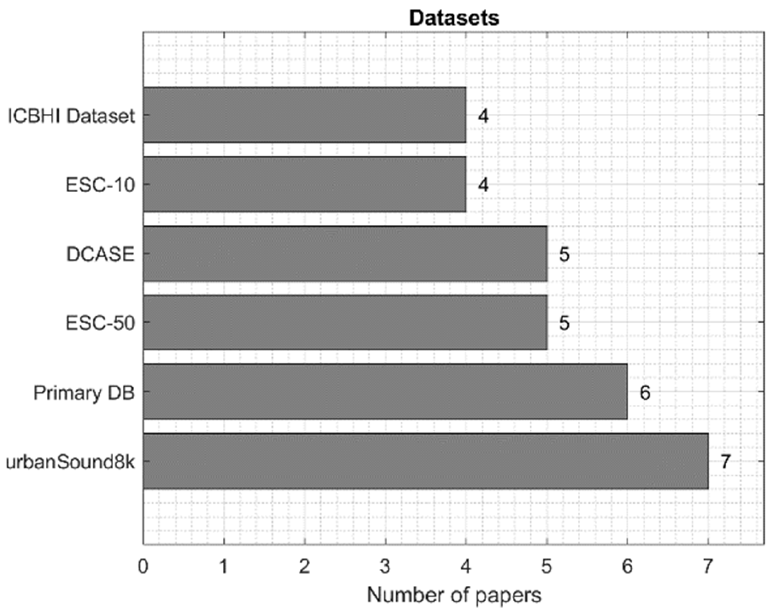
Figure 8. Audio/sound datasets used in the analyzed articles.